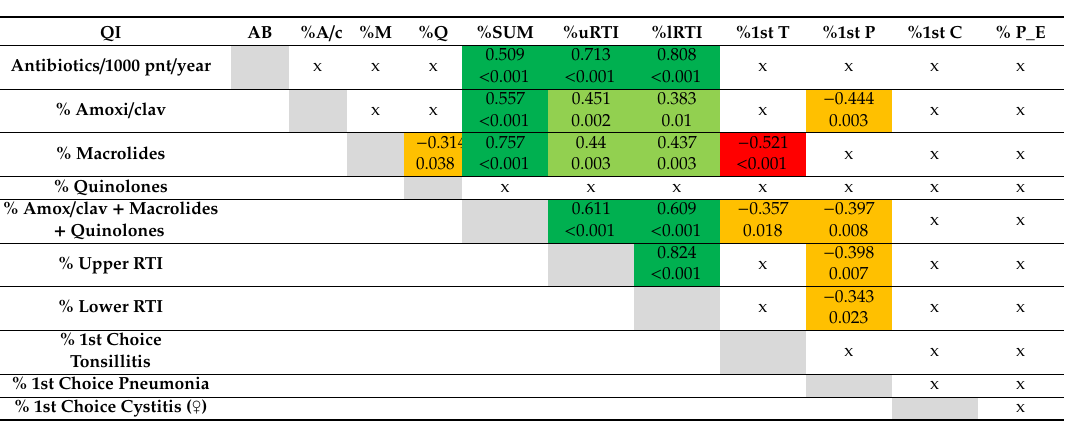
Table 2. Correlations between the quality indicator outcomes.